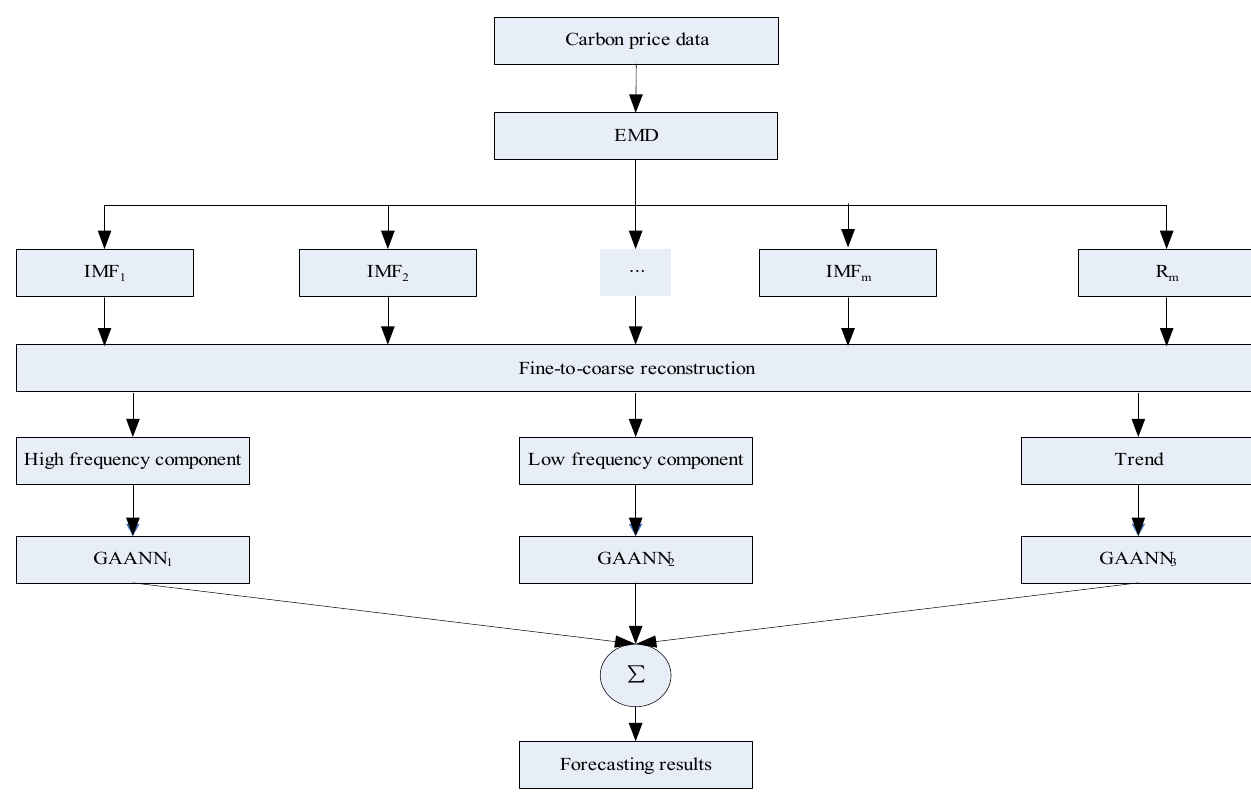
Figure 2. EMD-based GAANN multiscale ensemble prediction